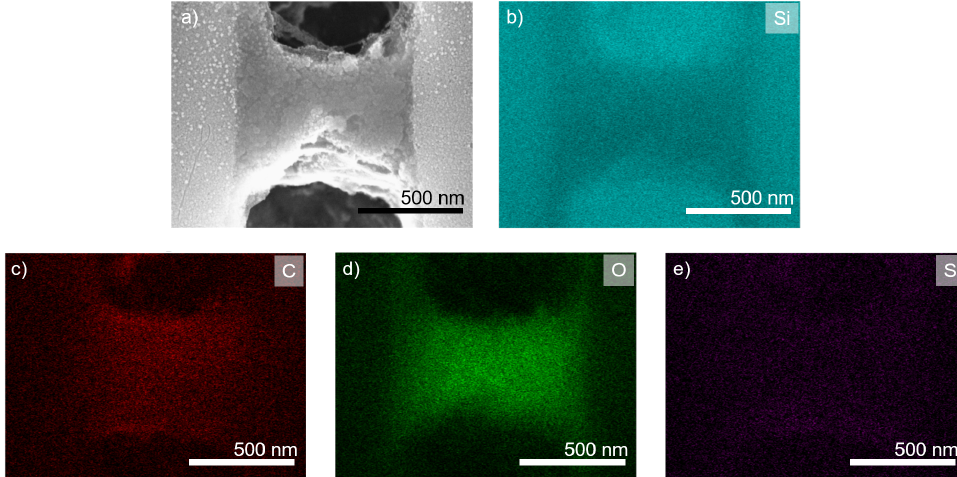
Figure 7. SEM image and EDX analysis of a cross sectional view of seven bilayers PDADMAC/PSS on isoporous silicon support with fully air-filled support during polyelectrolyte complexation. ( a ) SEM image, ( b ) EDX silicon signal, ( c ) EDX carbon signal, ( d ) EDX oxygen signal, and ( e ) EDX sulphur